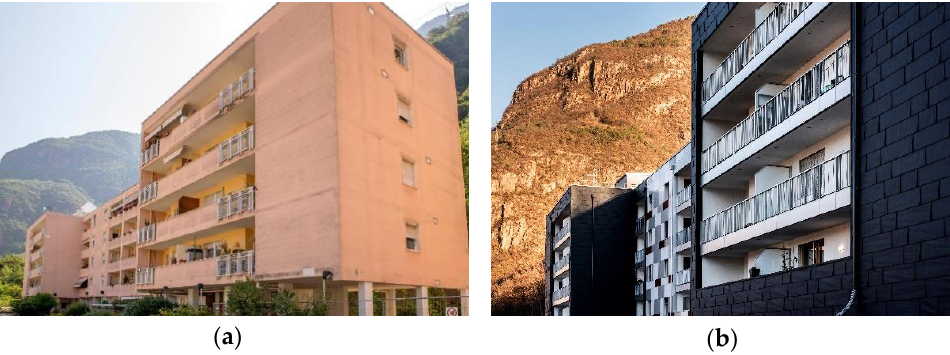
Figure 7. North building before ( a ) and after ( b ) the intervention (source: © Ivo Corrà).